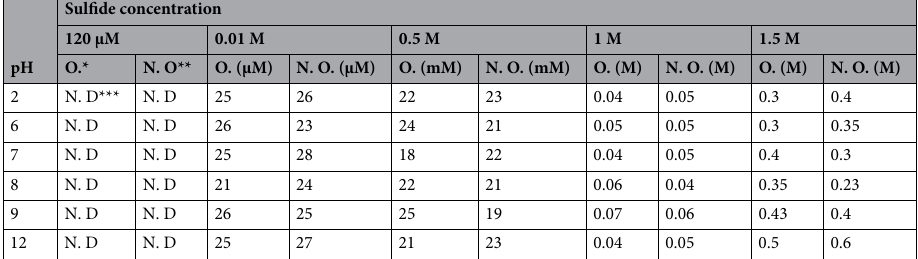
Table 3. Results of the investigation of sulfide oxygenation under different conditions of pH, oxygenation and sulfide concentration. *O.: Stands for oxygenated. **N. O: Stands for not oxygenated. ***N. D: Stands for Not